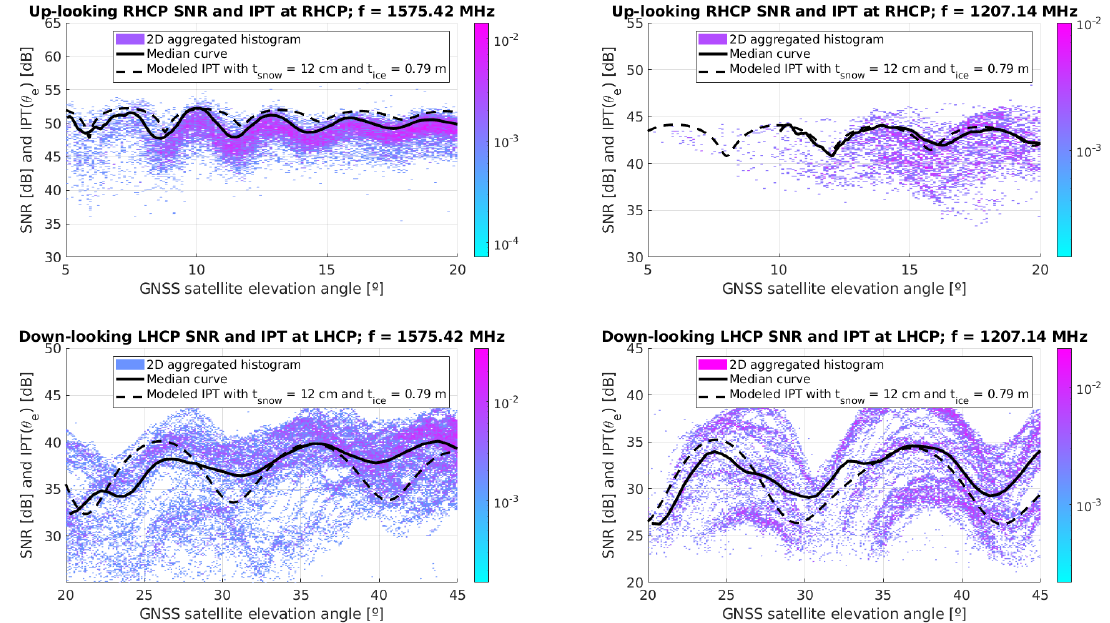
Figure 15. Modeled IPT using the retrieved snow and ice thickness overlaid on top of the signals retrieved by the PYCARO-2 instrument in the MOSAiC campaign during December 2019. Both the median curves and the modeled interference patterns are represented in black.